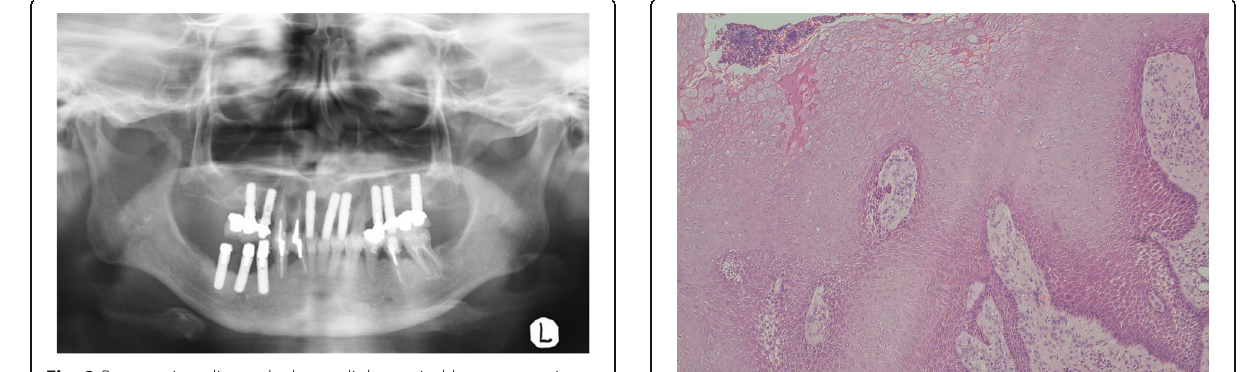
Fig. 2 Panoramic radiograph shows slight vertical bone resorption around the implants in the right side of the mandible